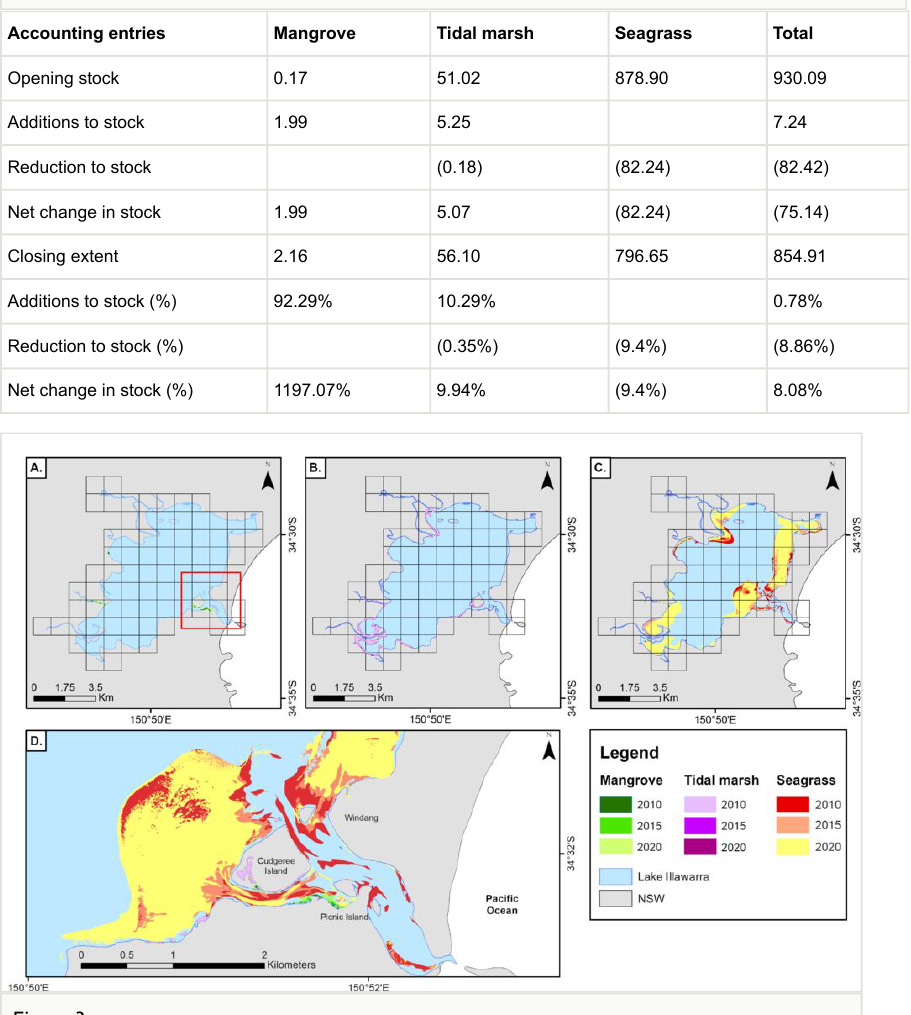
Lake Illawarra change in extent (Ha) account (2010 to 2020) for mangrove, tidal marsh and seagrass ecosystem types.